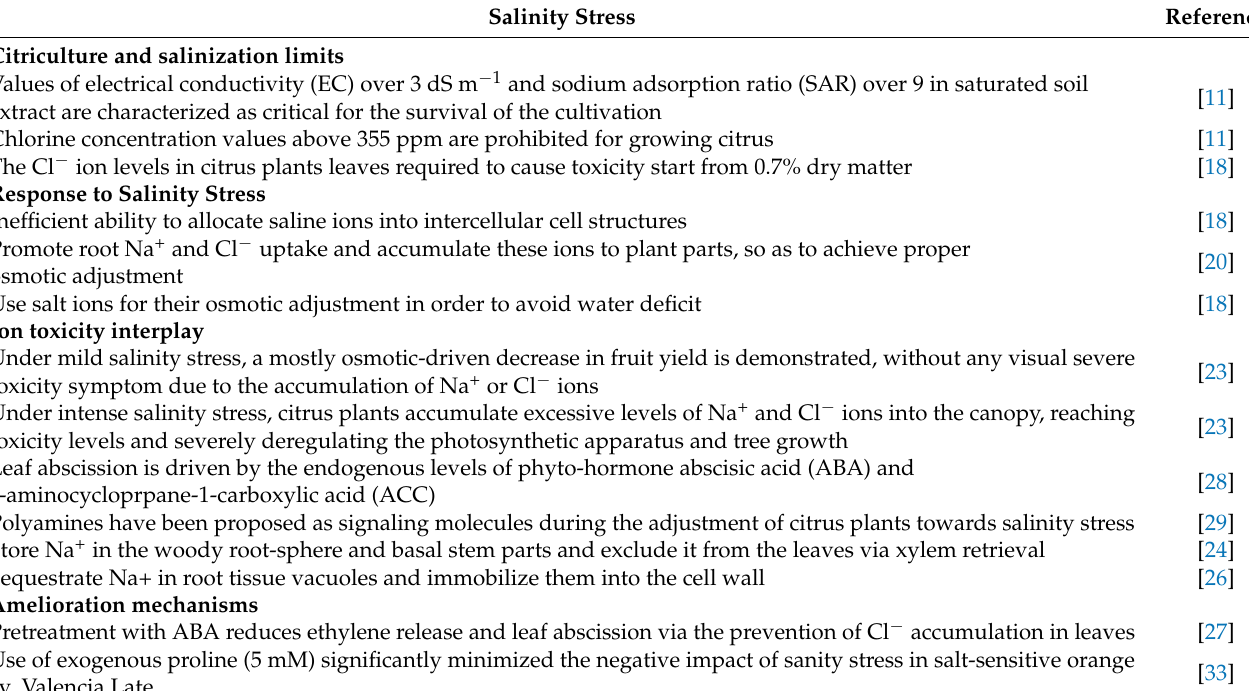
Table 1. Citriculture and salinity/drought stress